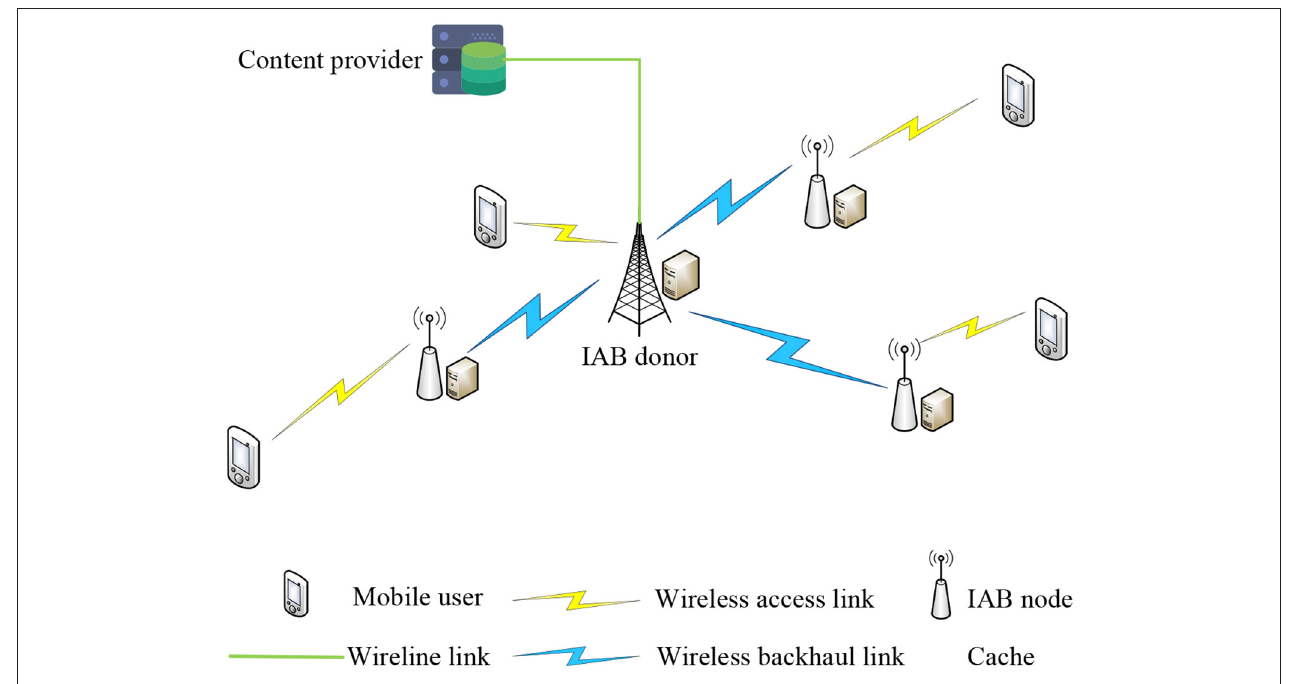
FIGURE 5 | Cache-enabled IAB network